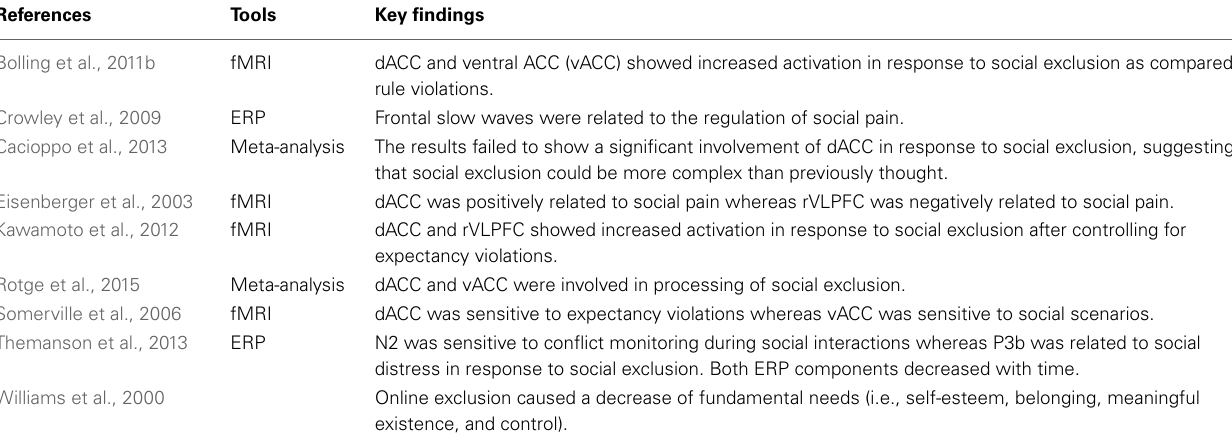
Table 1 | Key studies on intrapersonal processes of social